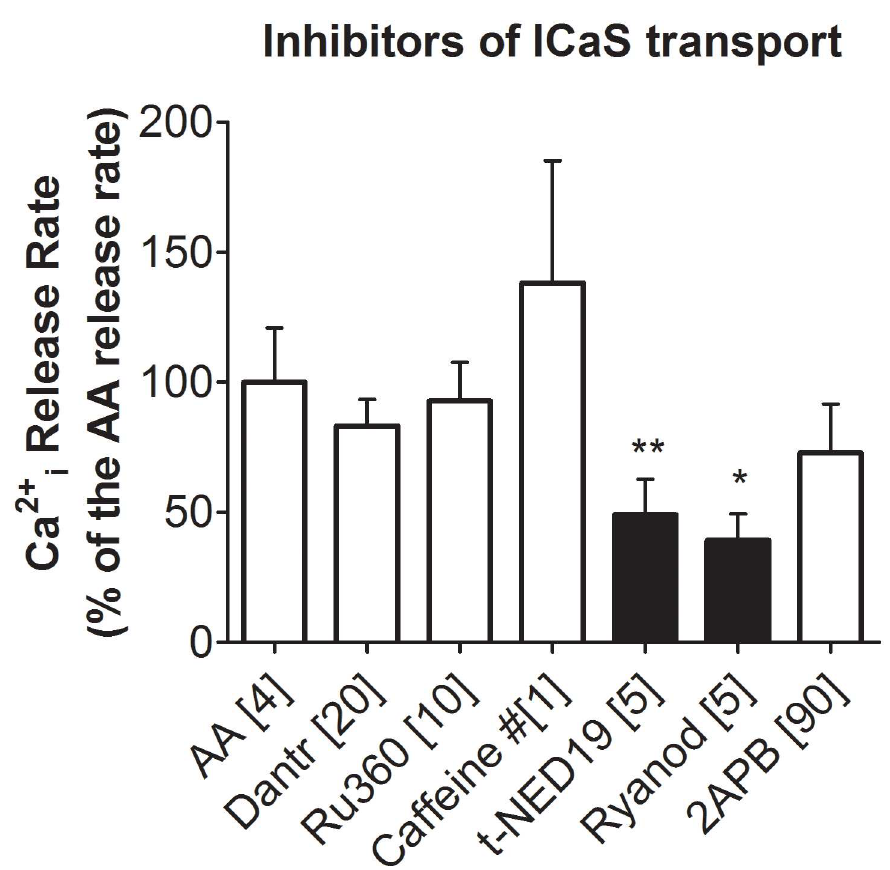
Fig 5. Effects of modulators of ICaS Ca 2+ uptake or releasechannels. Effects of inhibitors of Ca 2+ uptake or release channels form ICaS on the AA-induced(4 μ M) release of Ca 2+ from intracellularstores. Dantrolene (20 μ M) and ryanodine(5 μ M) are inhibitorsof the cADPr-activated channelor Ryanodine Receptorchannel (RyR). Caffeine (1 mM) is an activator of the RyR1 channel. NED19 (5 μ M) is an inhibitor of the NAADP two- pore activated channel. RU360 (10 μ M) is an inhibitorof mitochondrial Ca 2+ uptake. 2APB (90 μ M) is an inhibitorof IP3-activated channels. These channelmodulatorswere added to the cells in